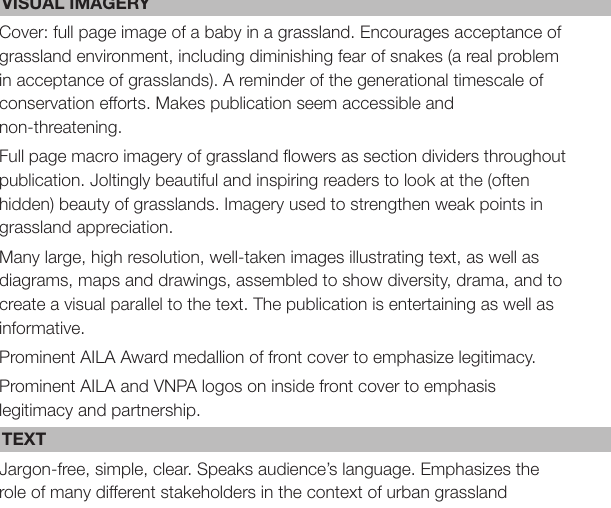
TABLE 3 | Communication strategies used in SWTG that contributed to its success. VISUAL